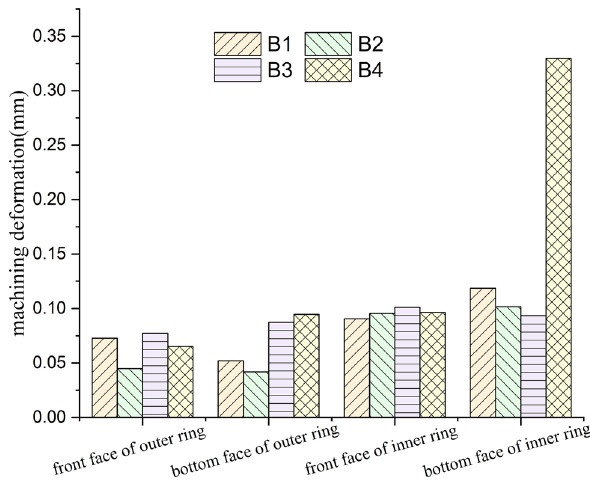
Figure 11: The analysis of the friction disc machining deformation.